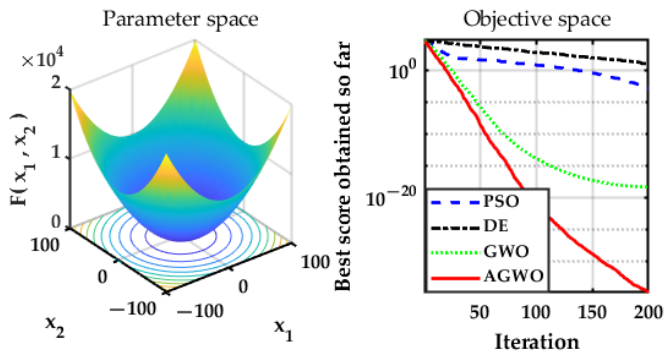
Figure 7. Convergence effect of convex function.